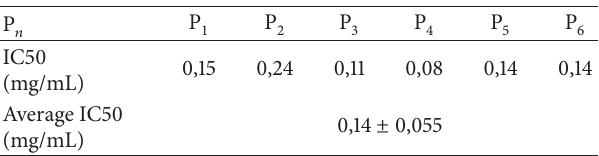
Table 1: IC50 of HFME.